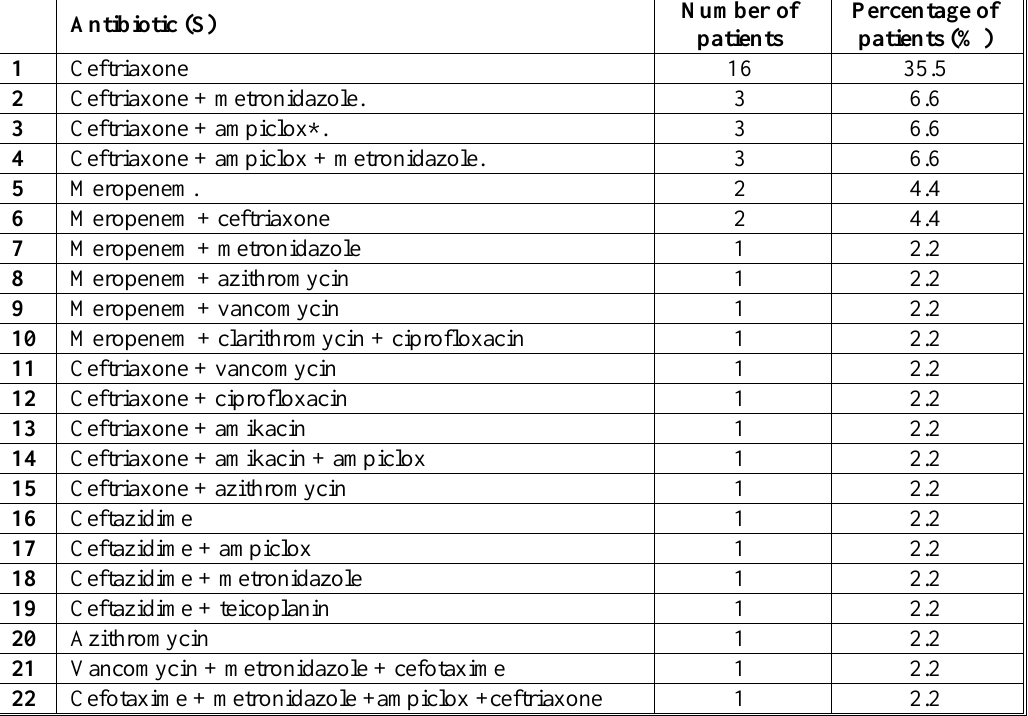
Table (1): Antibiotics used for empiric treatment. Antibiotic